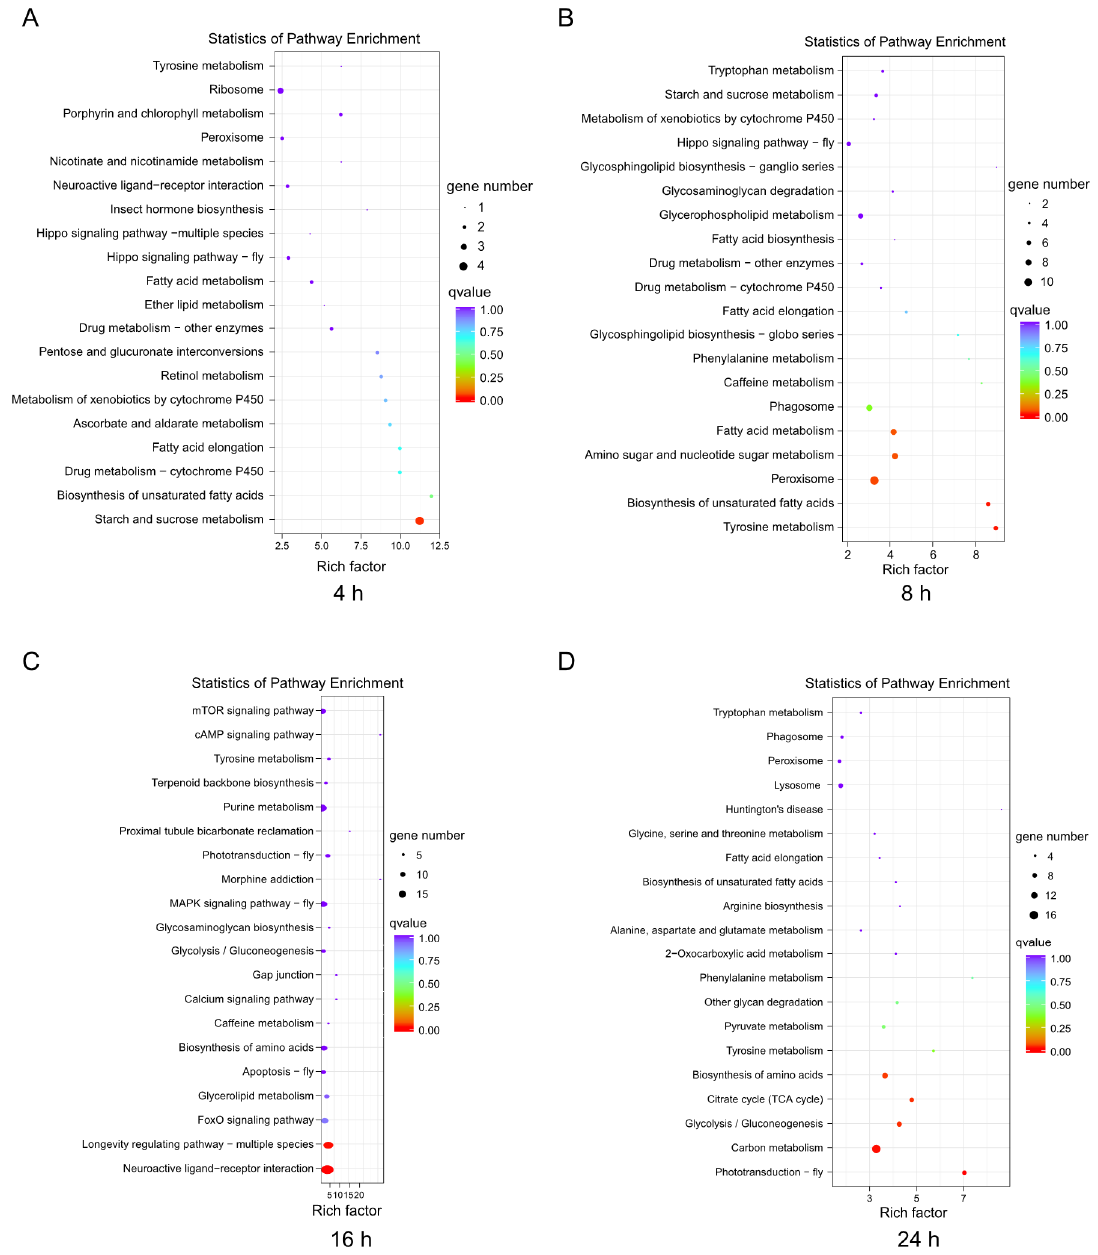
Figure 4. Enrichment and dispersion point map of differentially expressed genes (DEGs) in